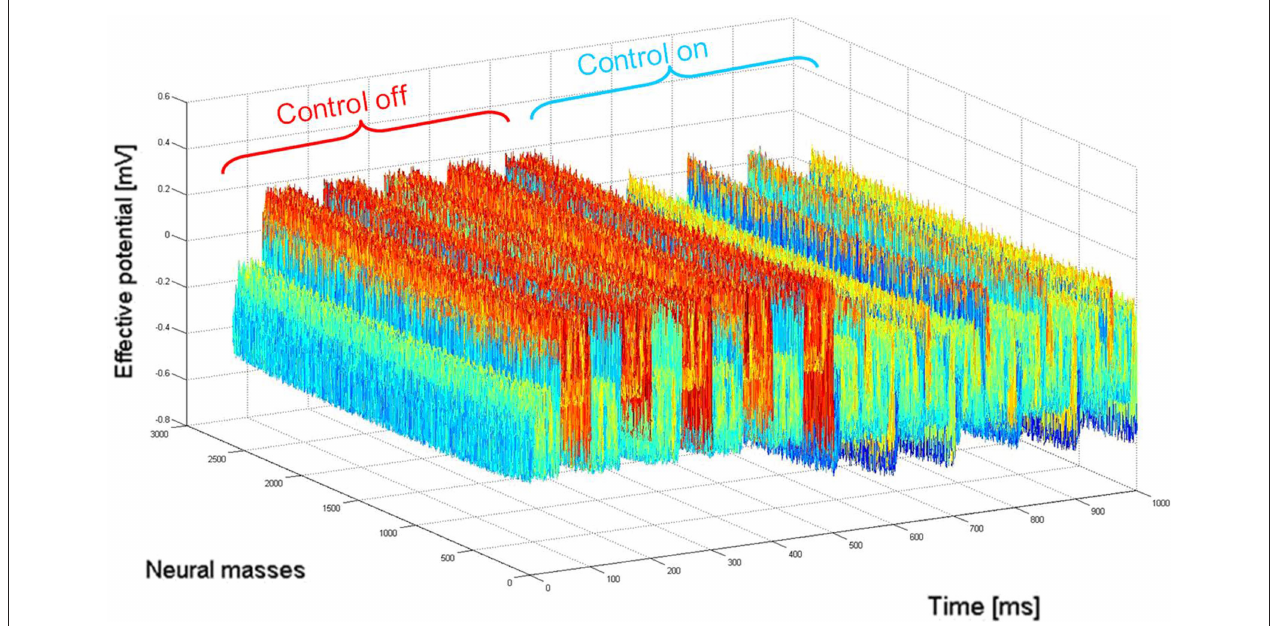
and 1000 ms) controlling network activity in space and time. When the stimulation signal is present, the network is still active in other (“physiological”) frequency bands, i.e., network activity are not completely suppressed by the stimulation